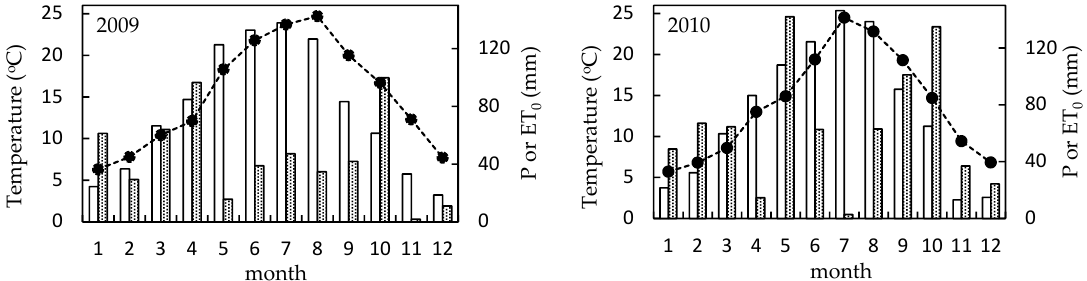
Figure 3. Monthly mean air temperature, precipitation (P) (dark columns), and reference evapotranspiration (ET 0 ) (white columns) at the experimental site in years 2009 and 2010. Data are from the meteorological station of Els Hostalets de Pierola (1 ◦ 48’31” west (W), 41 ◦ 31’59” north (N)).